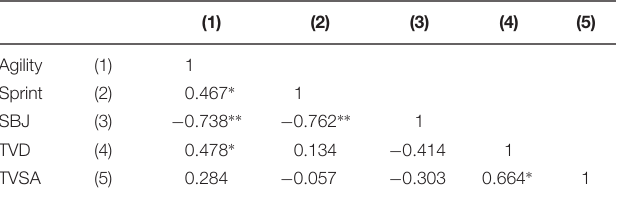
Pearson correlation between Agility, Sprint, Standing Board Jumping (SBJ), Times of Visual Discrimination (TVA), and Times of Visual Selective Attention (TVSA) in Sedentary Group. Significant value was showed with ∗ p < 0.05 and ∗∗ p <